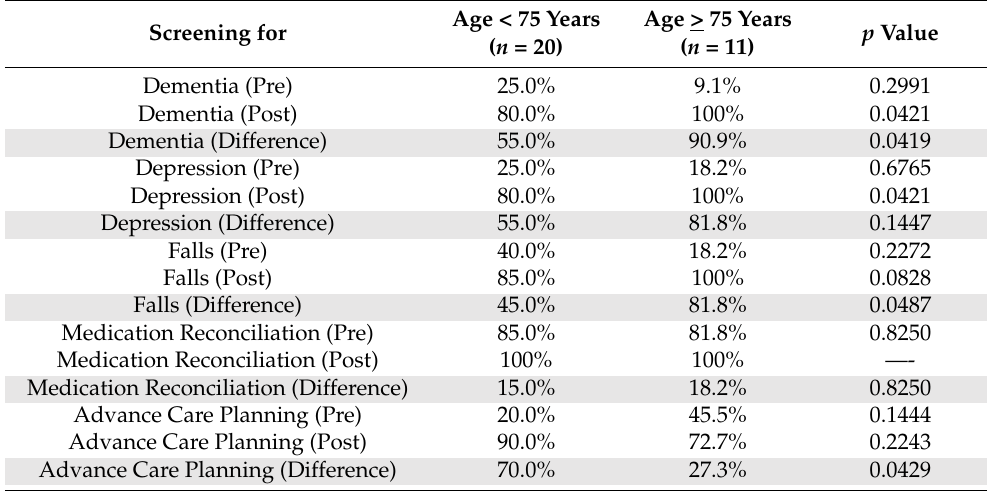
Table 2. Difference in screening for geriatric syndromes before and after participating in the annual wellness visit, stratified by age group. ( n = 31 with complete data).